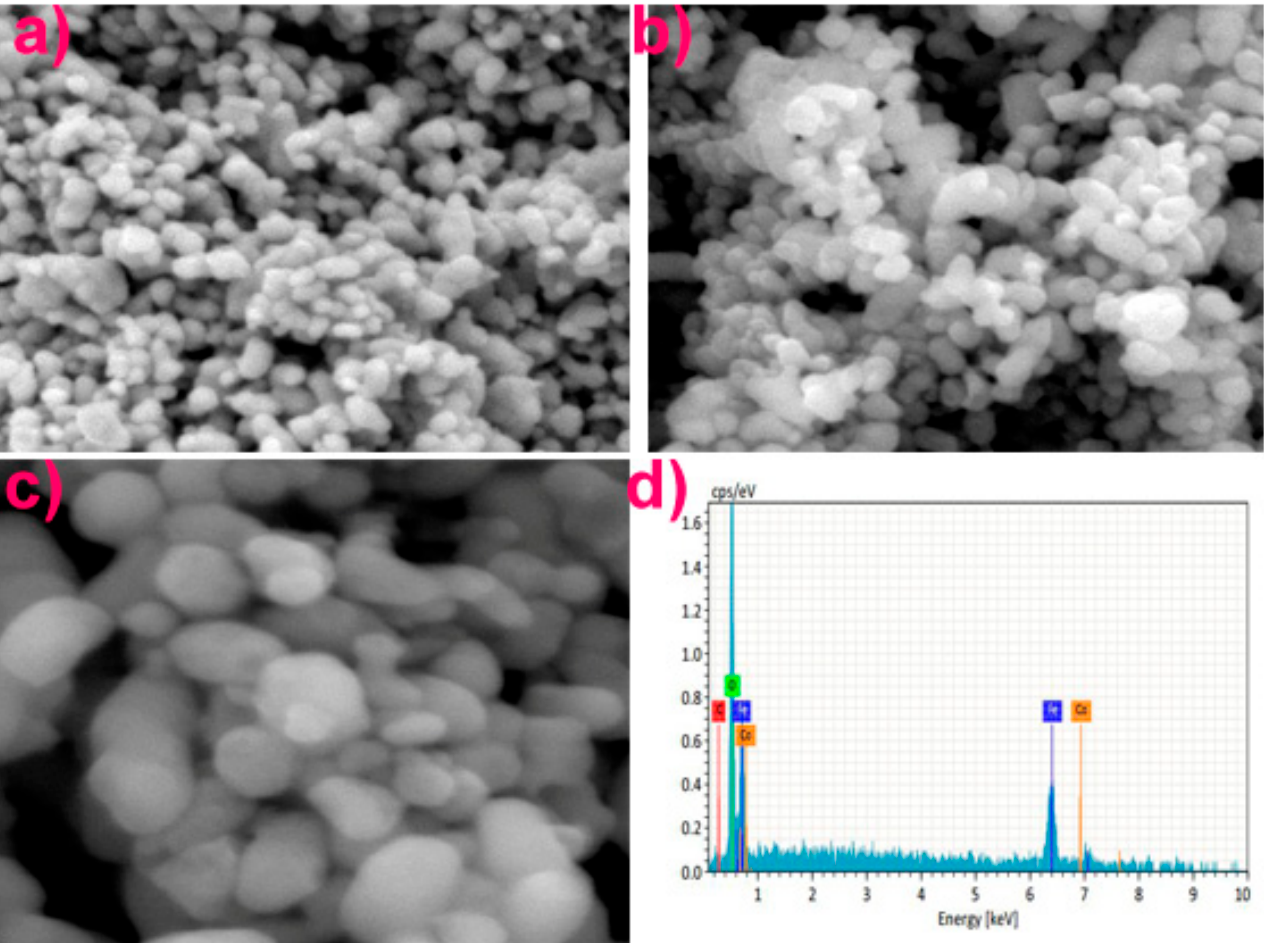
Figure 5. SEM images ( a–c ) and EDX ( d ) spectrum of biosynthesized CoFe 2 O 4 nanoparticles.